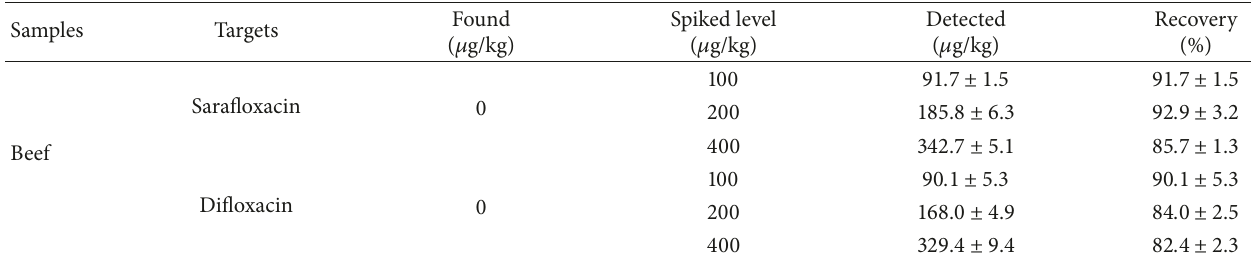
Table 4: Recovery study of sarafloxacin and difloxacin in spiked sample by CE (mean ± SD, 𝑛 = 3 ).